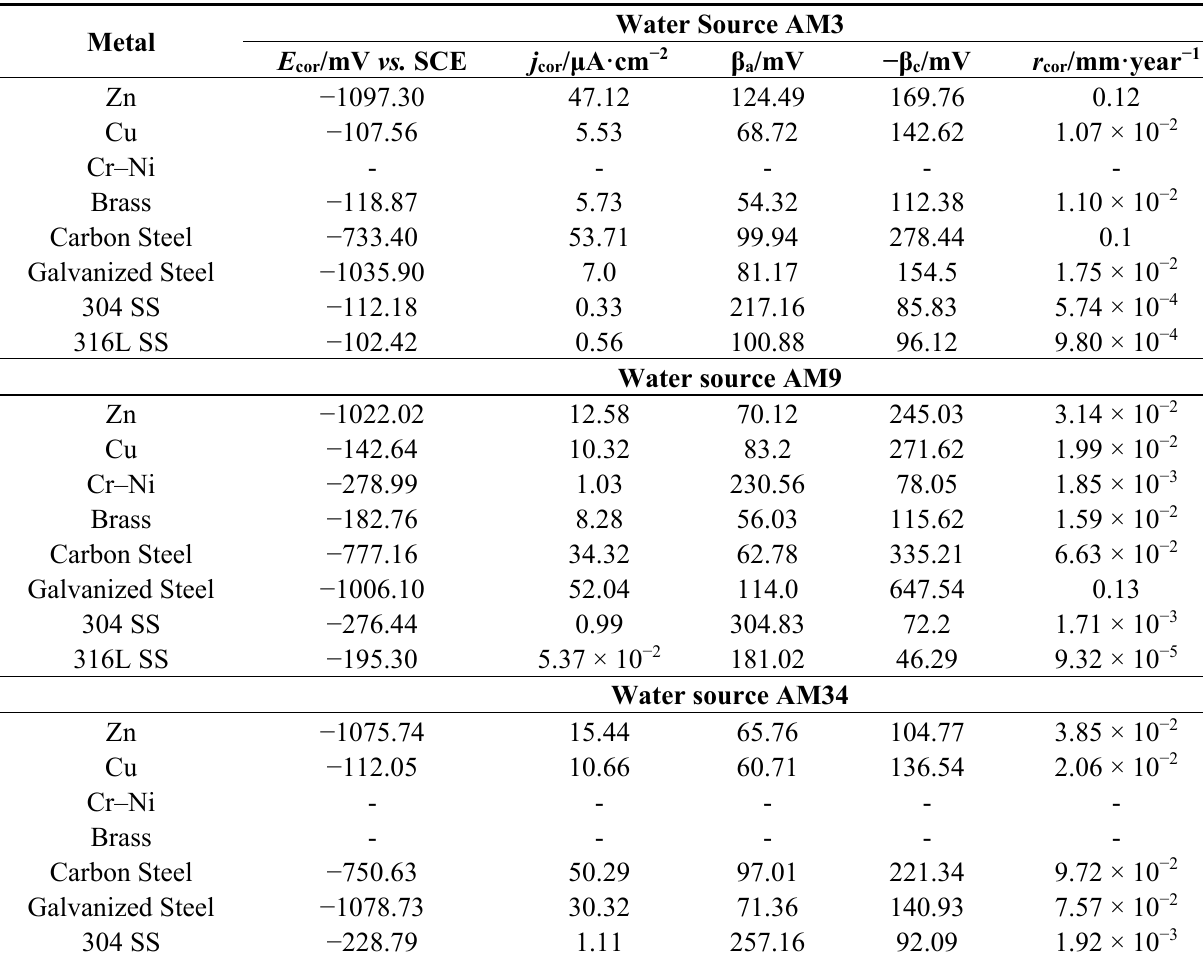
Figure 7. Cyclic polarization curves measured for various metal specimens during their immersion in thermal water taken from source AM34. Scan rate: 5 mV·s − 1 . Measurements were performed in the naturally aerated water at ambient temperature. Table 4. Corrosion parameters obtained from potentiodynamic polarization experiments of indicated metals immersed in water samples taken from three springs in São Miguel